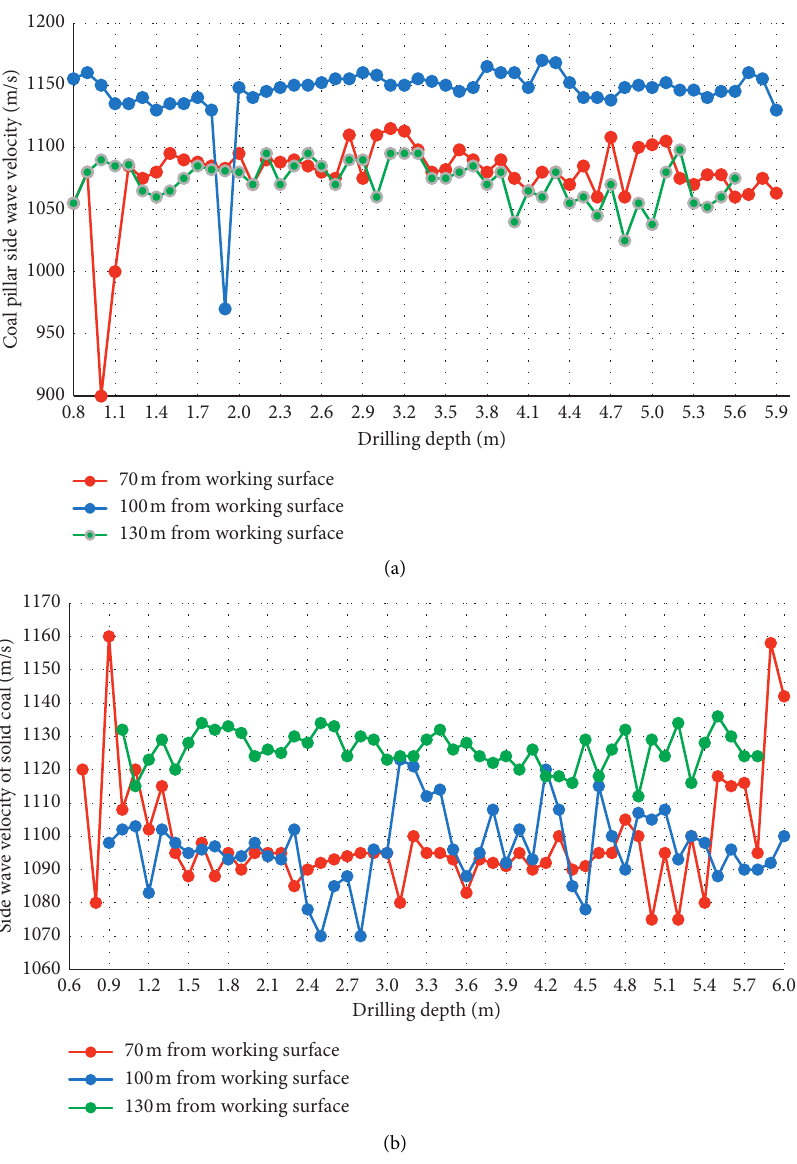
Figure 15: Ultrasonic detection results of the surrounding rock cracks in the roadway at different advanced positions from the 203 working face: (a) coal pillar side and (b) solid coal